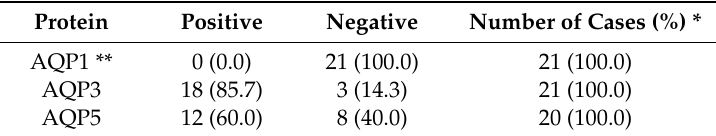
Immunoexpression of AQP1, AQP3, and AQP5 in salivary gland mucoepidermoid carcinoma